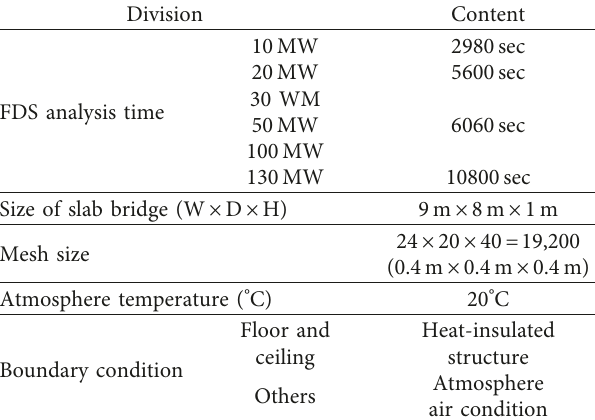
Figure 7: (a) FDS analysis model and (b) position of temperature measurement. Table 10: Characteristics of analysis